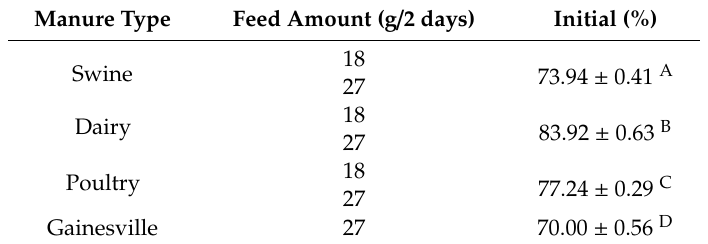
Table 2. Initial moisture contents (mean ± SE) of swine, dairy, and poultry manure, and Gainesville [32] for the black soldier fly